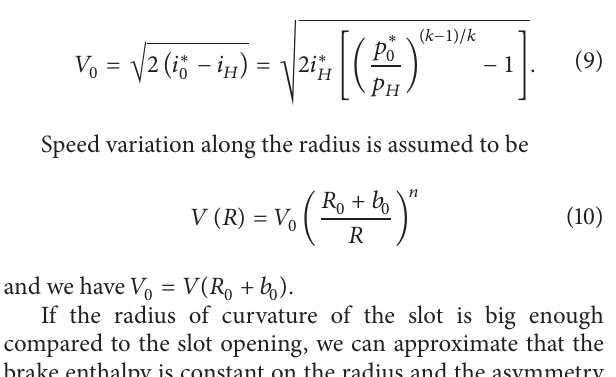
Figure 3: Jet flow elements.